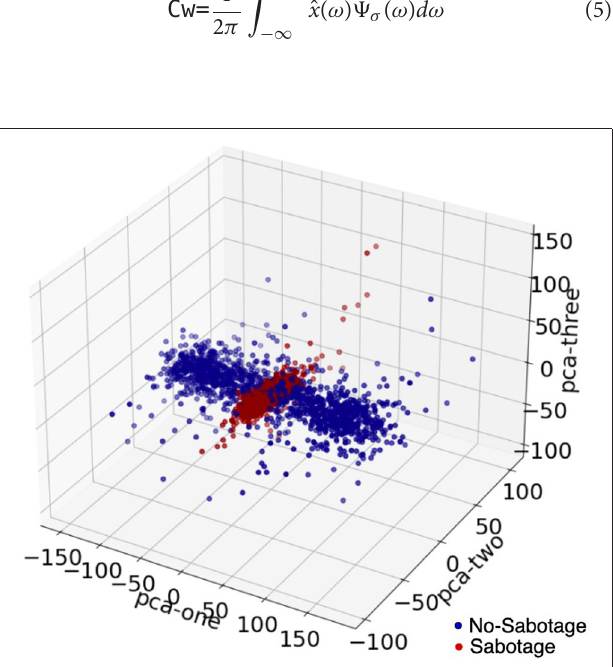
FIGURE 5 | The visualization of data using PCA in 3D; the above data are for Subject 1.